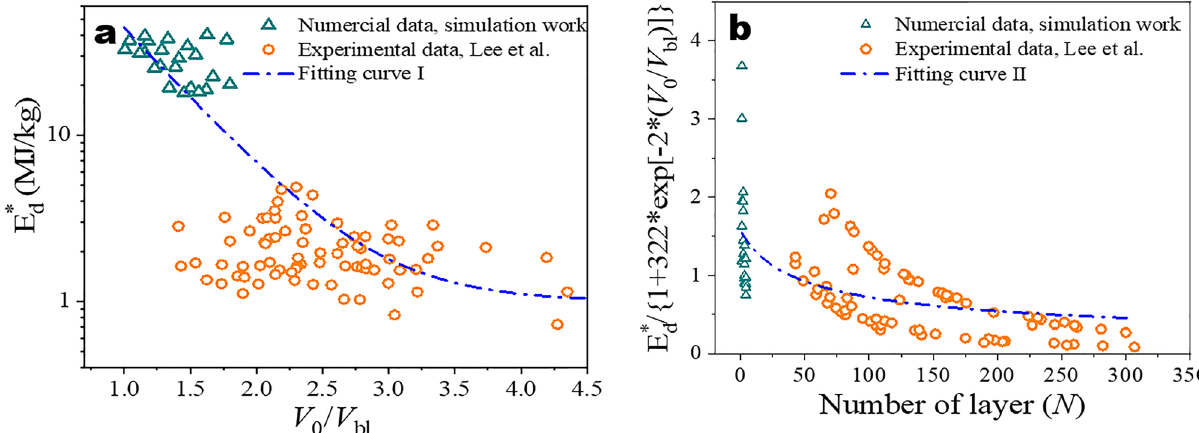
Figure 8. Specific penetration energy E ∗ d as a function of normalized initial impact velocity by ballistic limit velocity, V 0 / V bl and normalized specific penetration energy as a function of the number of graphene layer N